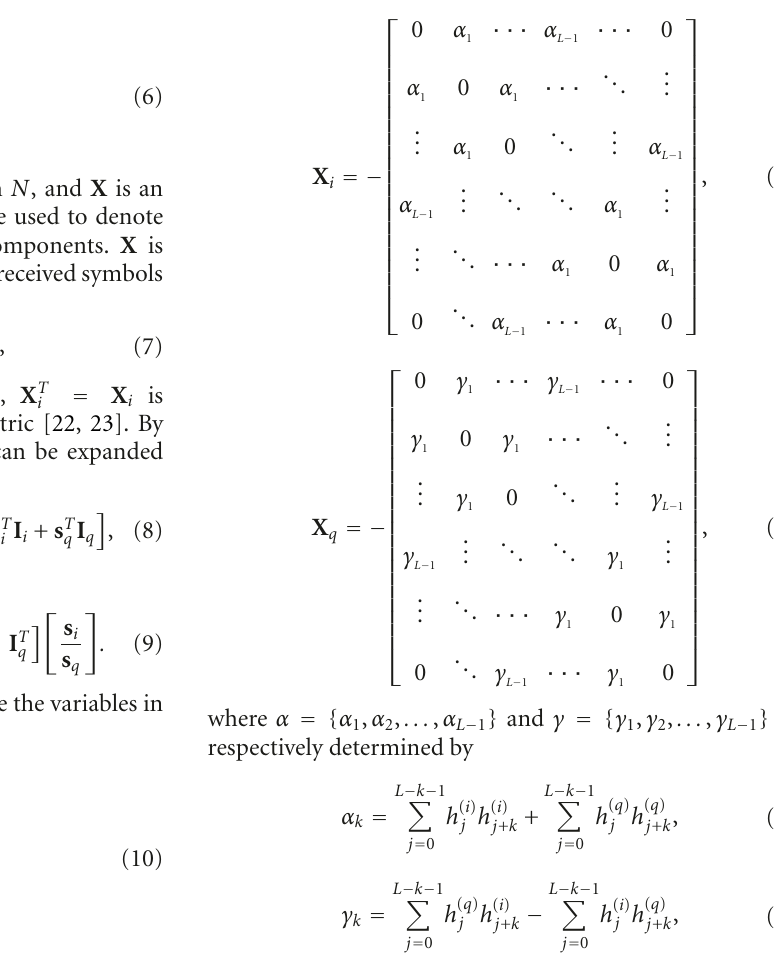
where I is a column vector with N elements, X is an N × N corresponds to the HNN energy function in (2). In